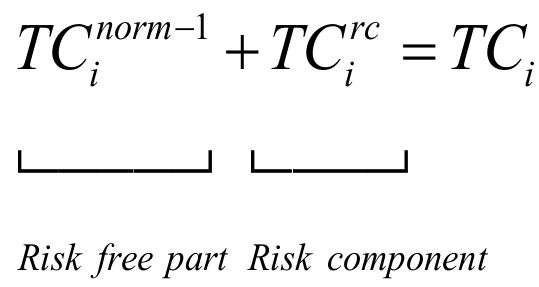
Figure 2. Scheme of component ratio of normal and recertative transaction